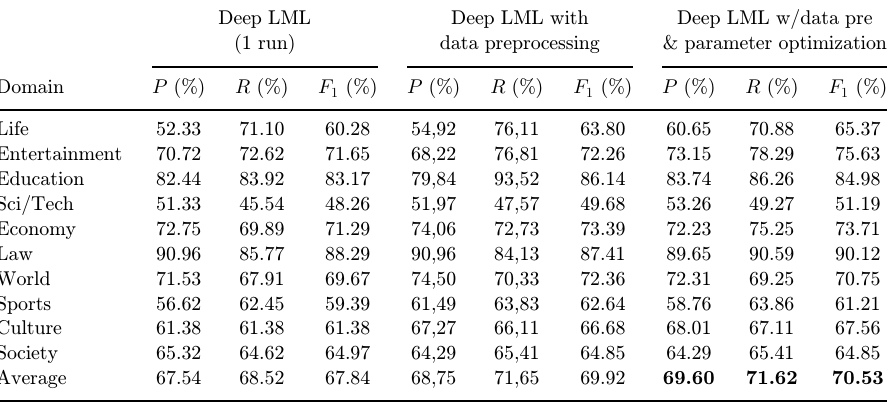
Table 9. Cross-domain with unlabeled data preprocessing and parameter